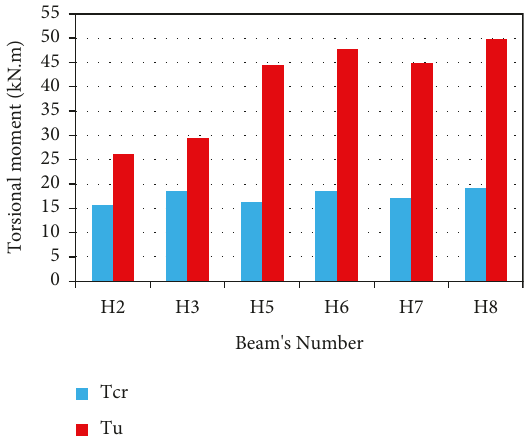
Figure 13: Load-carrying capacity of the tested beams.